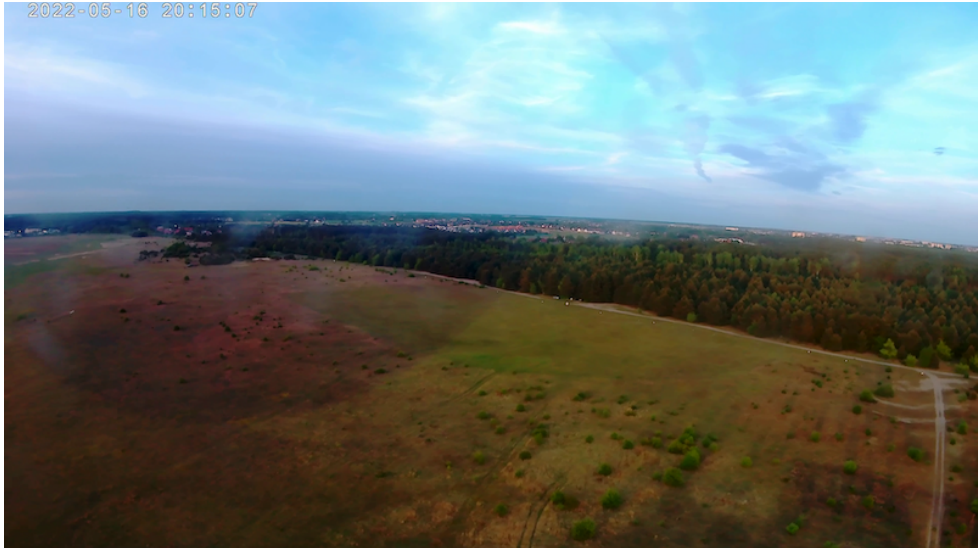
Figure 3. View from the on-board video camera; altitude ca. 55 m above the